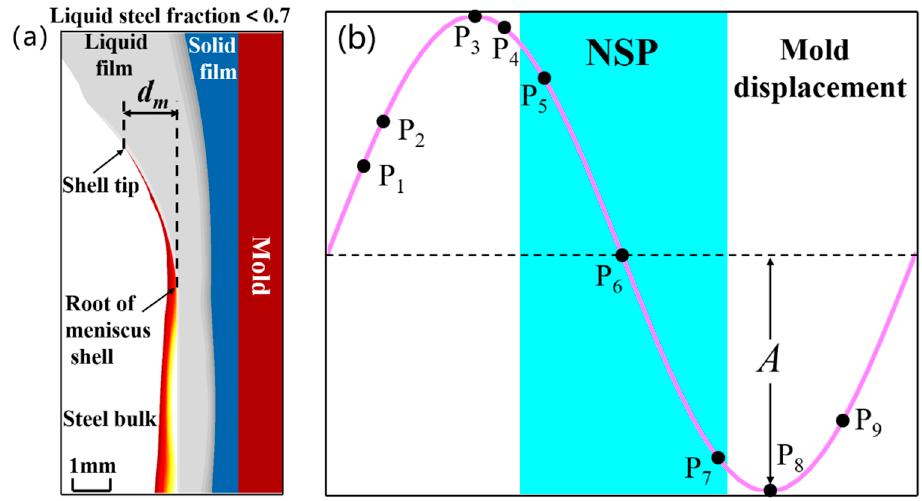
Figure 9. Schematic of ( a ) solidified shell tip at meniscus and ( b ) mold displacement.